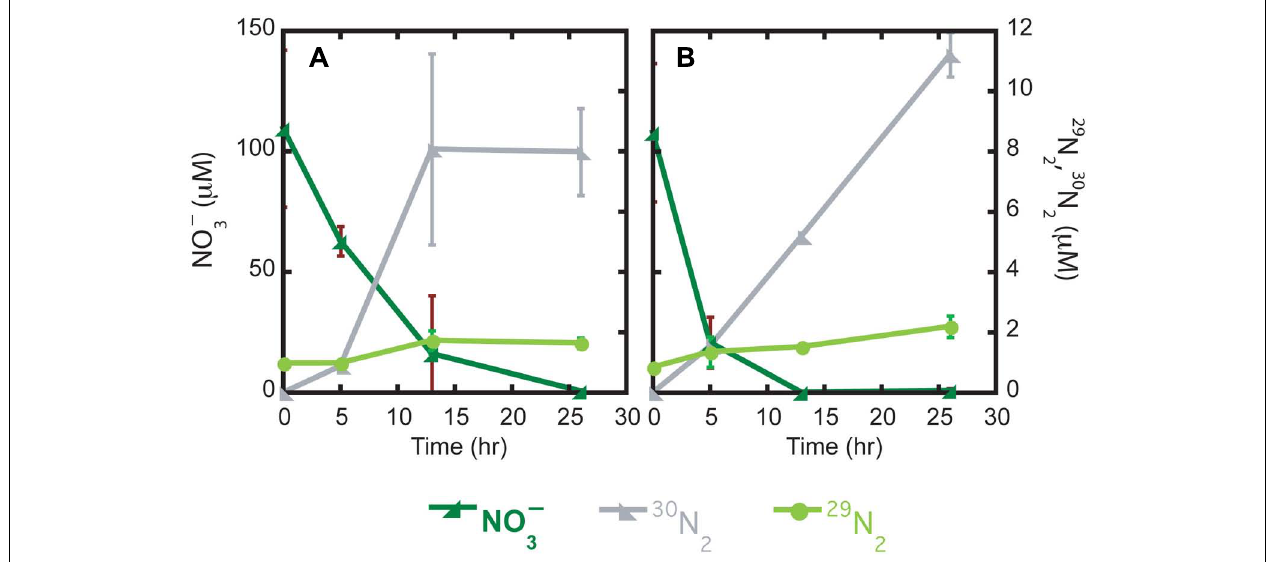
FIGURE 1 |Time series incubations of mat (A) and brown (B) sediments with the substrate (NO − 3 , μ M) and products ( 29 N 2 and 30 N 2 , μ M) plotted against time (h).